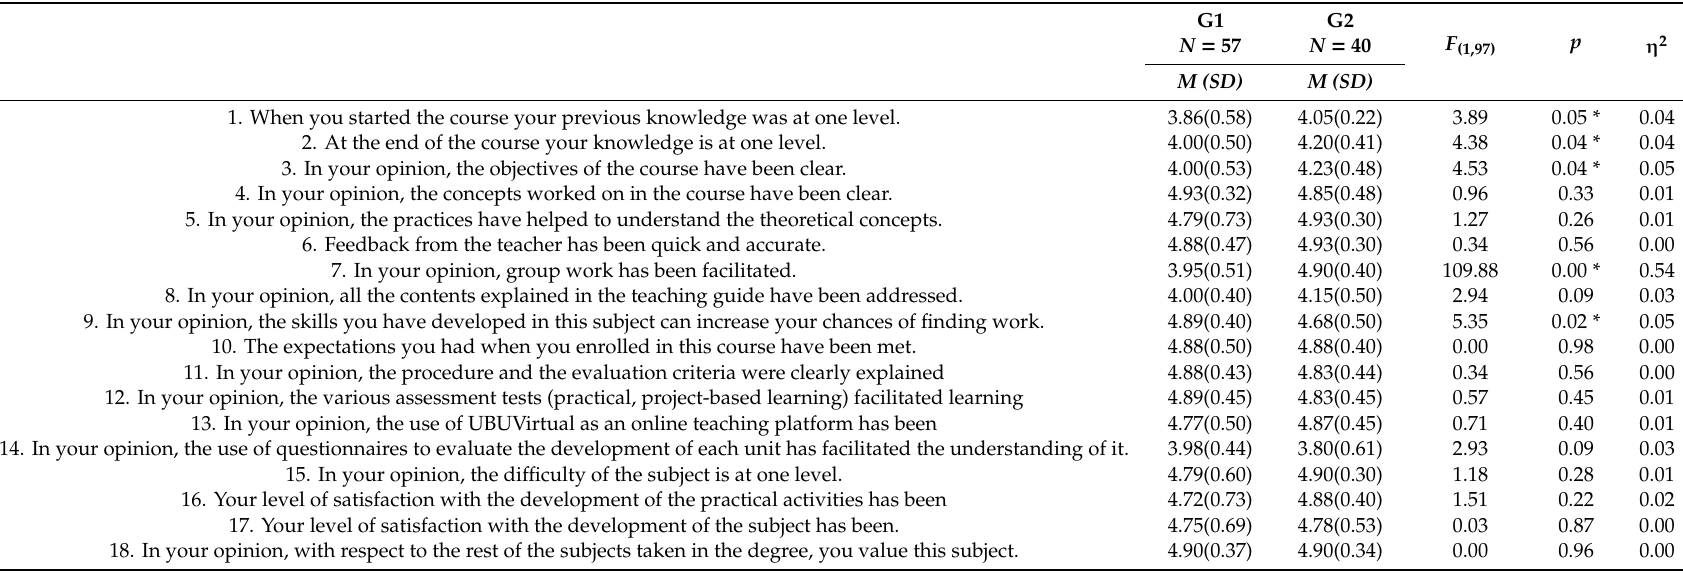
Table A3. Single factor fixed-e ff ects ANOVA (use of IPAs vs. non-use)